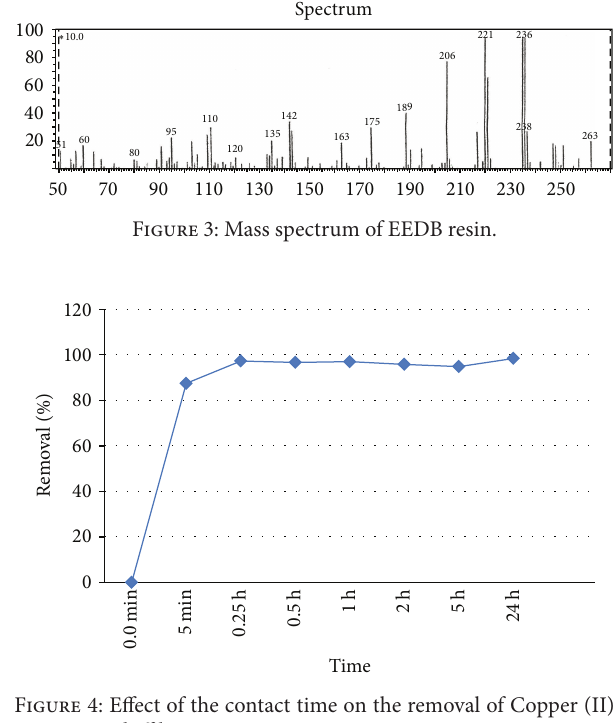
Figure 4: Effect of the contact time on the removal of Copper (II) ion using Schiff base.